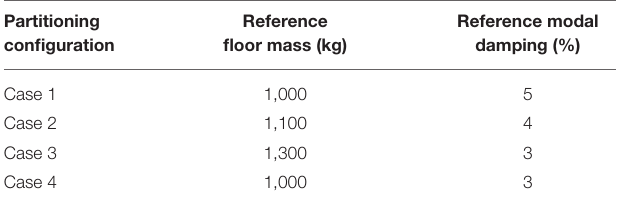
TABLE 1 | Virtual-RTHS partitioning cases proposed by Silva et al.